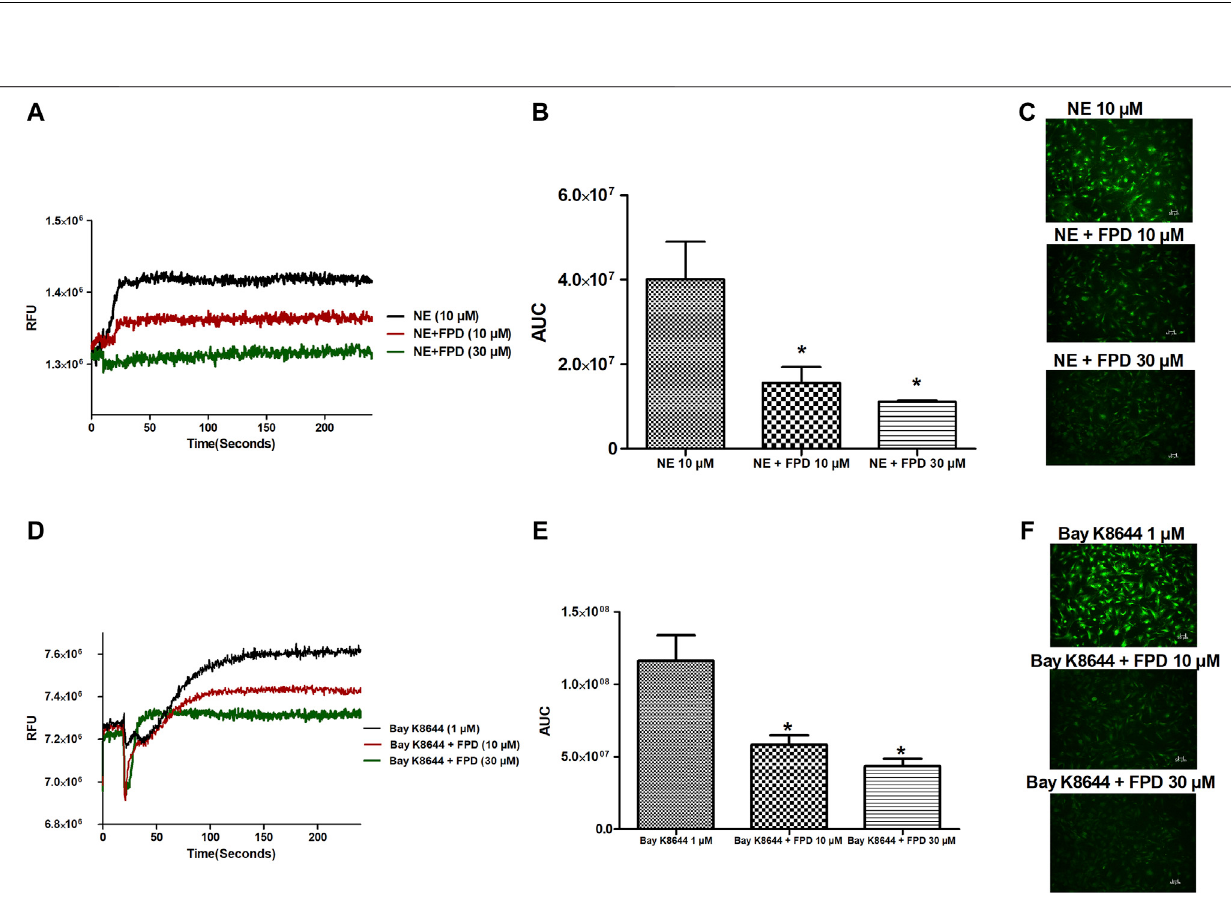
FIGURE 8 | Tracings of concentration dependent Bay K8644-induced contraction alone and in the presence of FPD (10 µM) and nifedipine (1 µM) in isolated rat superiormesentericartery (A) .Concentration responsecurveofBayK8644alone,incombinationwithFPD(10 µMfor20 min)andnifedipine(1 µM) (B) (mean ± S.E.M., n (cid:2) 8; * p < 0.05 compared to control).